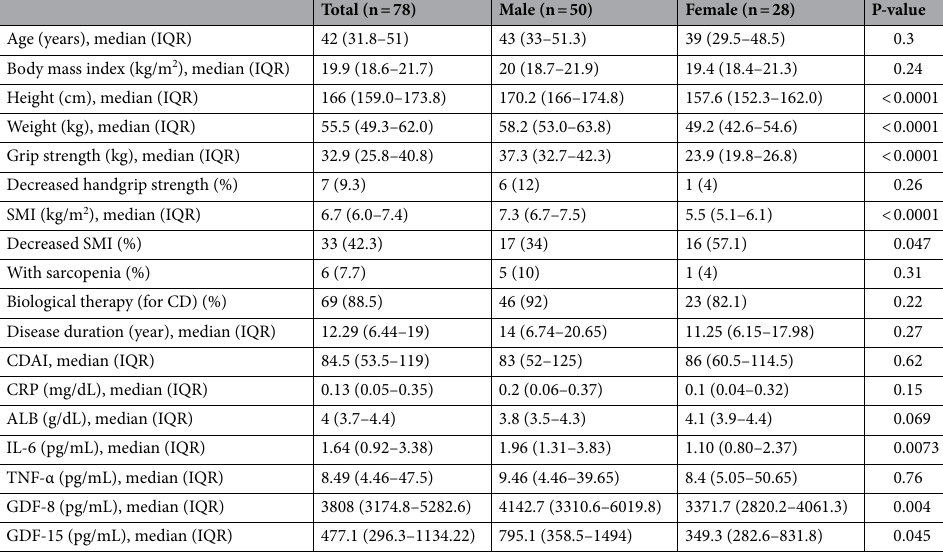
Table 1. Patients’ clinical characteristics. Data were analyzed using the U test or χ 2 test. BMI body mass index, differentiation factor-15, IQR interquartile range.